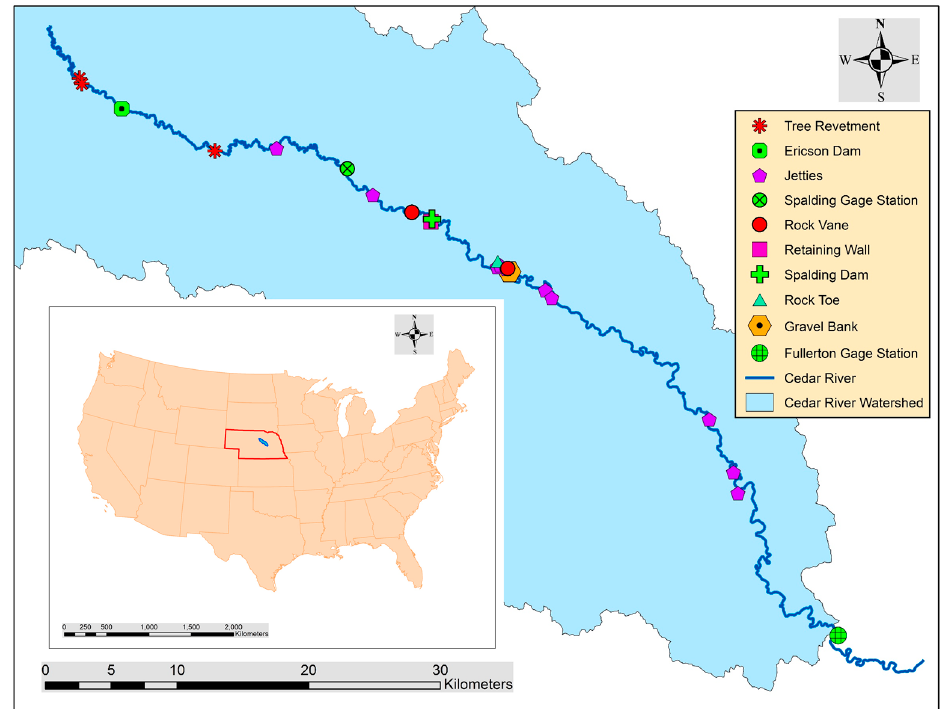
Figure 1. Locations of the dams, gage stations, and stabilized streambanks on the Cedar River in North Central Nebraska.